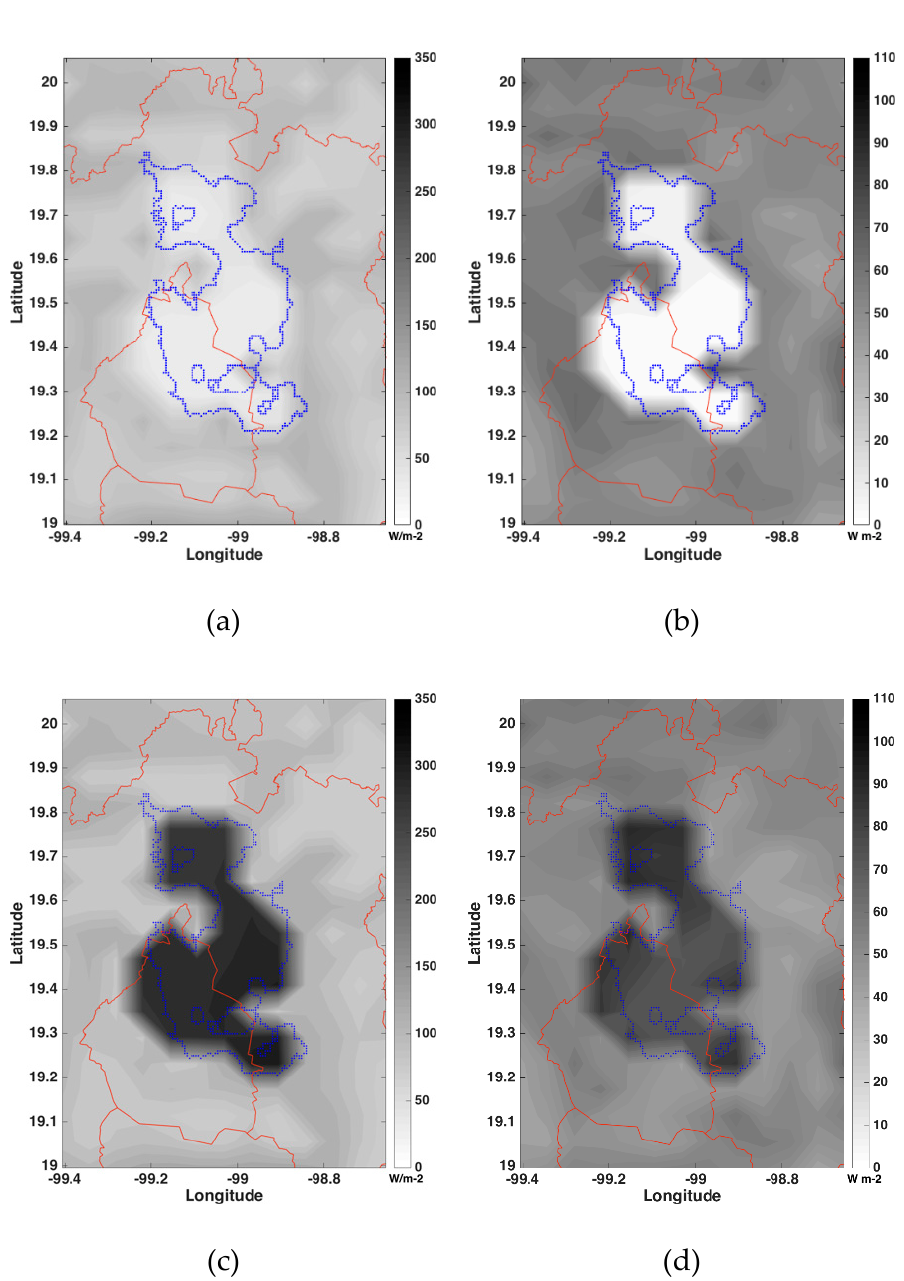
Figure 4. Mean monthly heat fluxes for the simulations with a lake system: latent ( a ) and sensible ( b ) heat fluxes for L / WRFu; latent ( c ) and sensible ( d ) heat fluxes for L / WRFc. Additionally, a significant change can be observed in the winds. Figure 5 shows the di ff erence of the average wind speed between No-Lake and Lake simulations for the uncoupled WRF (Figure 5a) and coupled WRF models (Figure 5b), and a snapshot of the wind vectors representing the changes in magnitude and direction for both WRFu and WRFc (Figure 5c,d, respectively). The lake system with the coupled WRF model (Figure 5b) increases, in general, the magnitude of the winds and modifies the regional circulation, which is dominated by a convergence zone that moves from the south to the central part of the lake system. Figure 5d shows this convergence zone in the central part of the lake